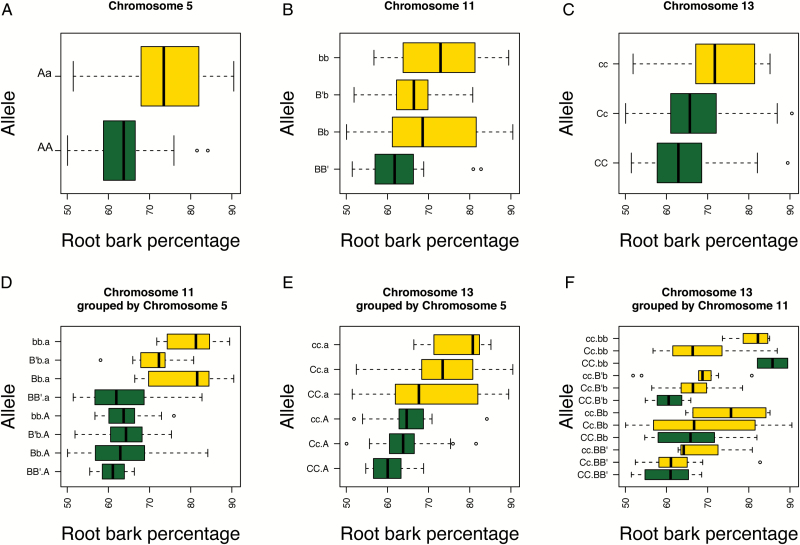
Boxplots depicting the effects of the rootstock genotype upon the expression of the root bark percentage trait. Rb1 alleles on LG05 are depicted as (A) in repulsion to the QTL and (a) in coupling with the QTL; Rb2 alleles on LG11 are depicted as (B) in repulsion to the QTL, ‘M.116’ allele, (B′) in repulsion to the QTL, ‘M.27’ allele, and (b) in coupling with the QTL; and Rb3 alleles on LG13 are depicted as (C) in repulsion to the QTL, and (c) in coupling with the QTL. (A) the effects of Rb1 when analysed alone. (B) The effects of Rb2 alone. (C) The effects of Rb3 alone. (D) pairwise comparisons of Rb1 and Rb2, revealing significant non-additive effects between Rb1 and Rb2, which vary depending upon the allelic combination at LG11. (E) This phenomenon is not observed for Rb1 and Rb3, which appears to exert an effect independent of Rb2. (F) Rb2 significantly affects the expression of Rb3, again dependent upon the allelic combination present at Rb2.